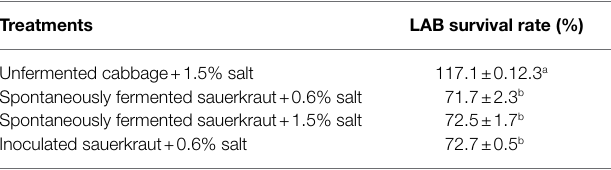
TABLE 1 | Salt concentration and inoculation do not affect lactic acid bacteria (LAB) survival rate during in vitro digestion. Treatments LAB survival rate (%) Unfermented cabbage + 1.5%